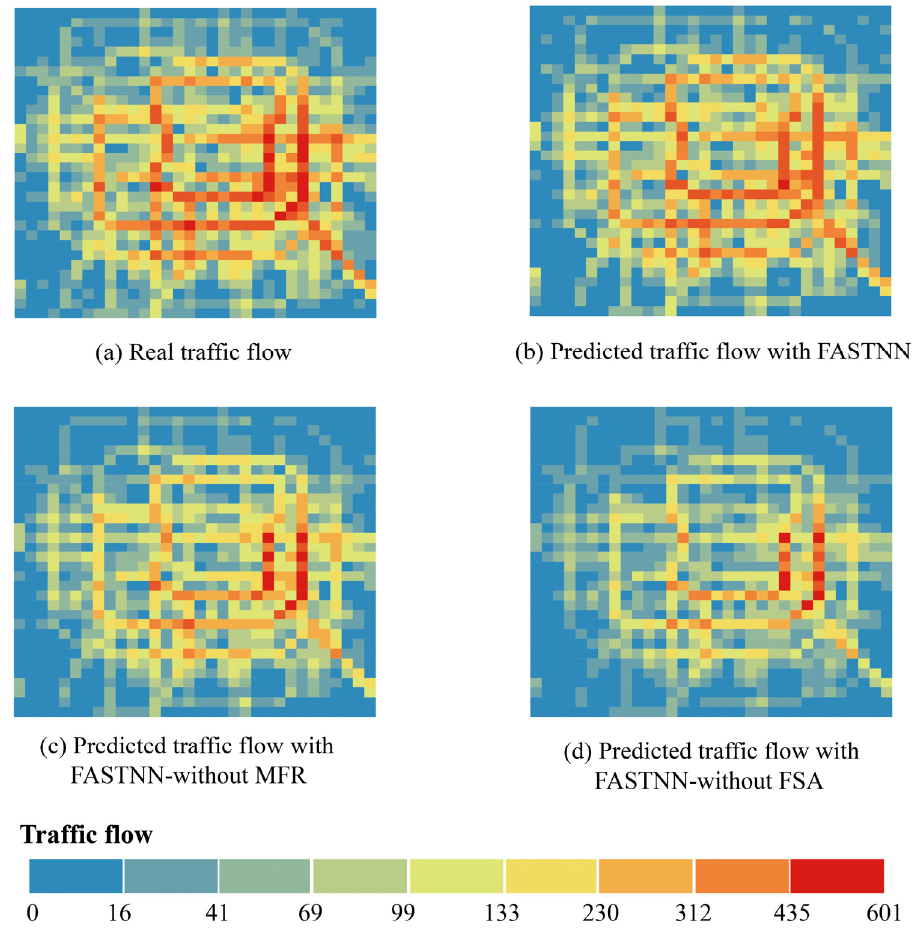
Figure 9. Real traffic flow and model prediction results.